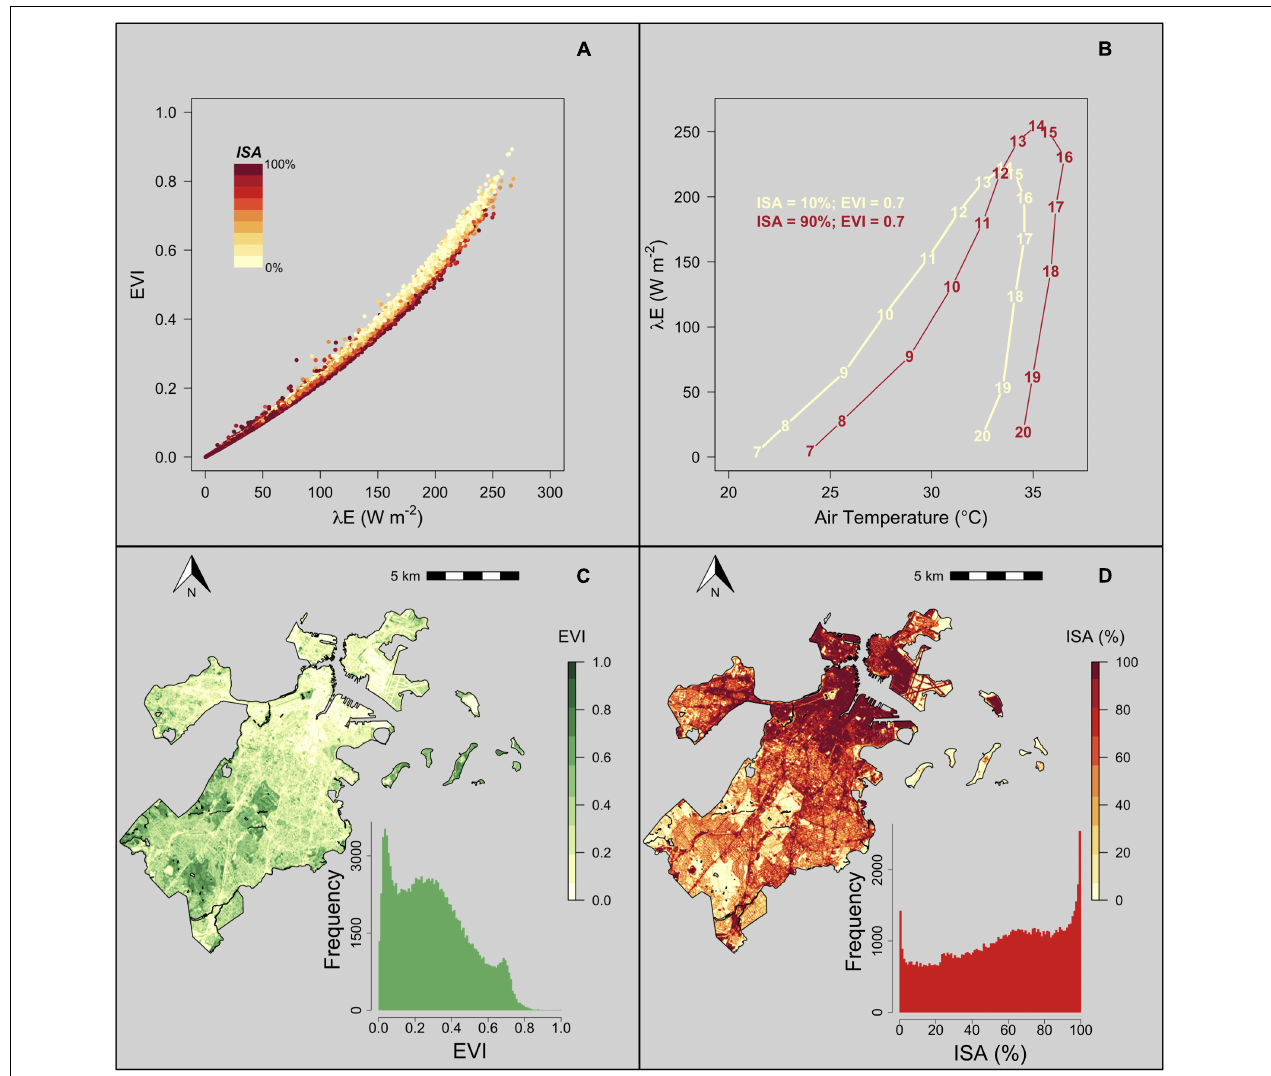
FIGURE 3 | (A) EVI vs. average 14:00 λ E color coded by ISA. (B) Diurnal hysteresis comparison of λ E as a function of air temperature in two pixels with EVI = 0.70 and ISA = 10 and 90%. Numbers represent the hour of day (EDT). (C) Map and distribution of EVI in Boston on August 2, 2018. (D) Map and distribution of ISA in